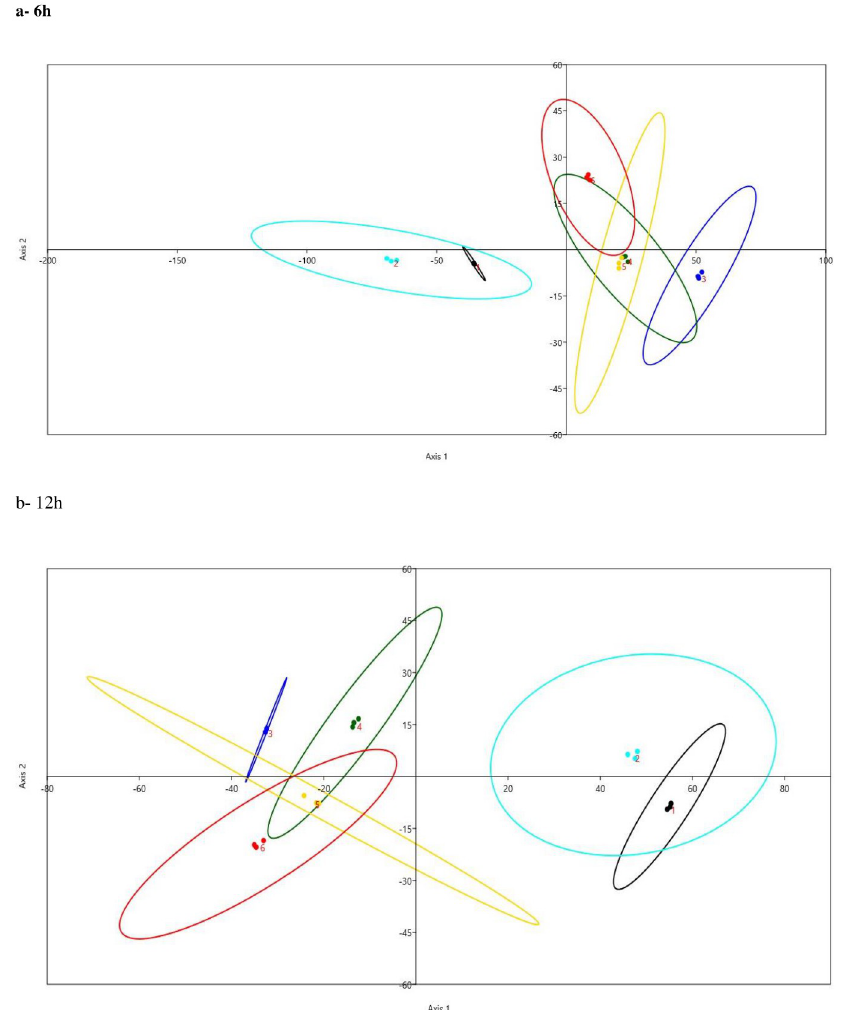
Fig 2. Linear Discriminate Analysis; LDA based on the values of disappearance of dry matter (DMD), neutral detergent fiber (NDFD), and crude protein (CPD) as well as the relative abundances of dominate bacterial phyla and genera attached to extracted and non-extracted plants in the rumen of camel at 6h (A) and 12 h (B); non-extracted atriplex (black dots), extracted atriplex (aqua dots), non-extracted acacia (blue dots), extracted acacia (dark green dots), non-extracted leucaena (gold dots), and extracted leucaena (red dots).